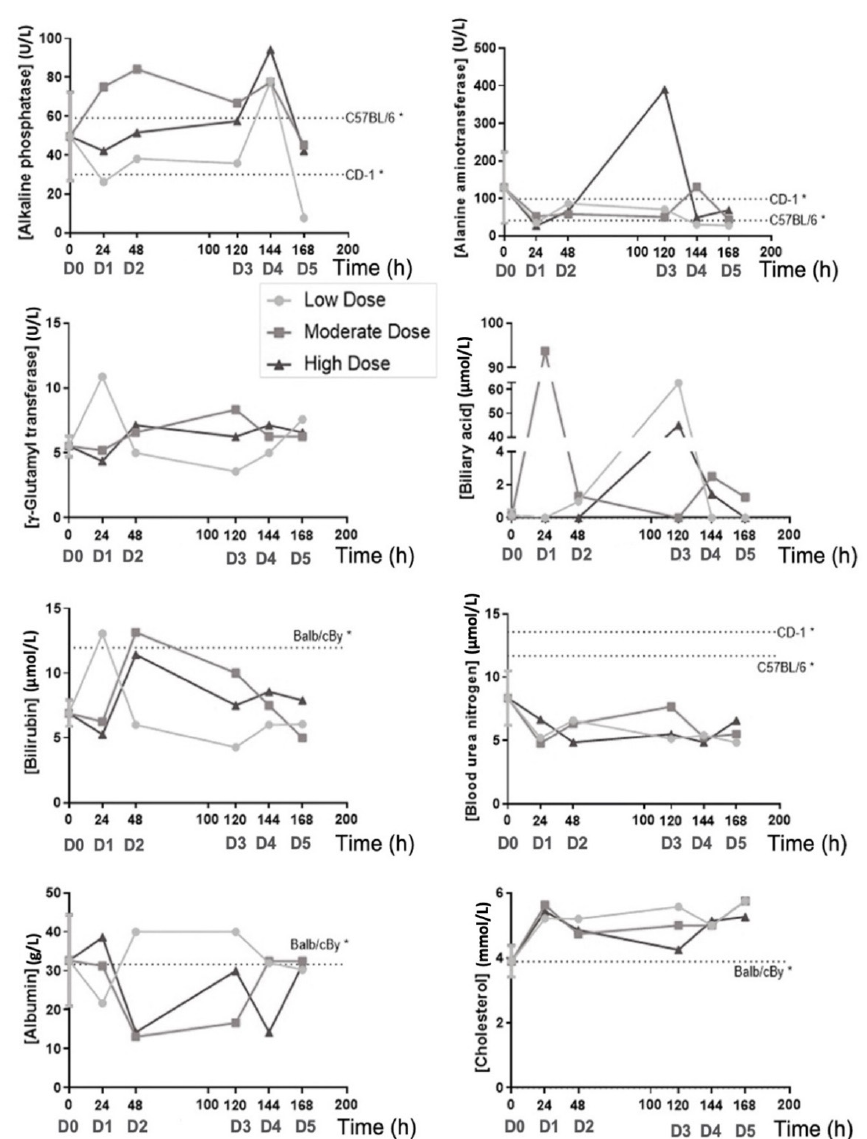
Figure 4. Biochemical profile of liver enzymes. Blood samples were extracted from 7 out of 15 mice